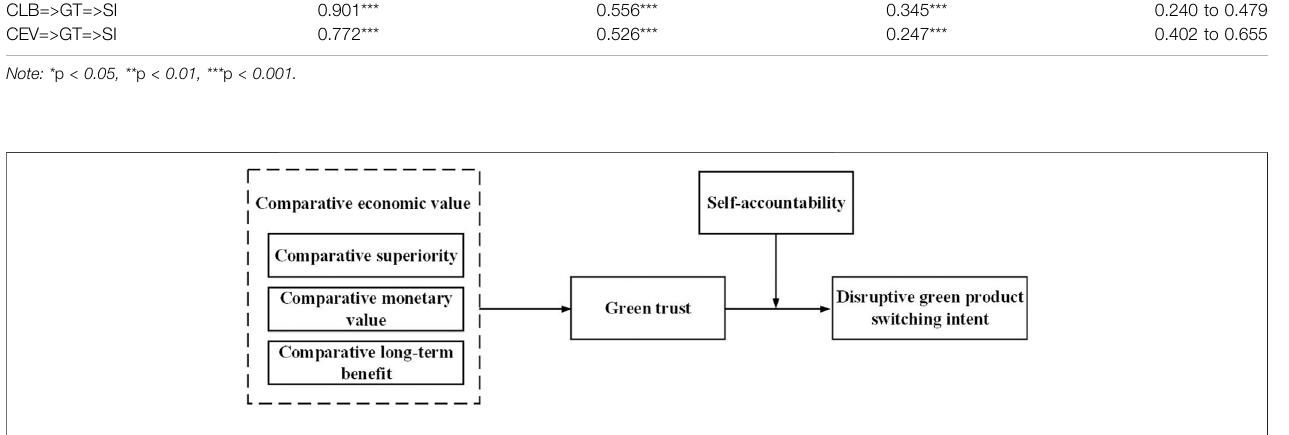
FIGURE 1 | Conceptual model of this study.